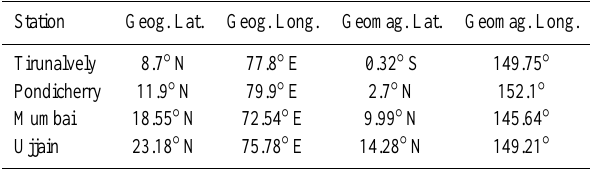
Table 1. Coordinates of